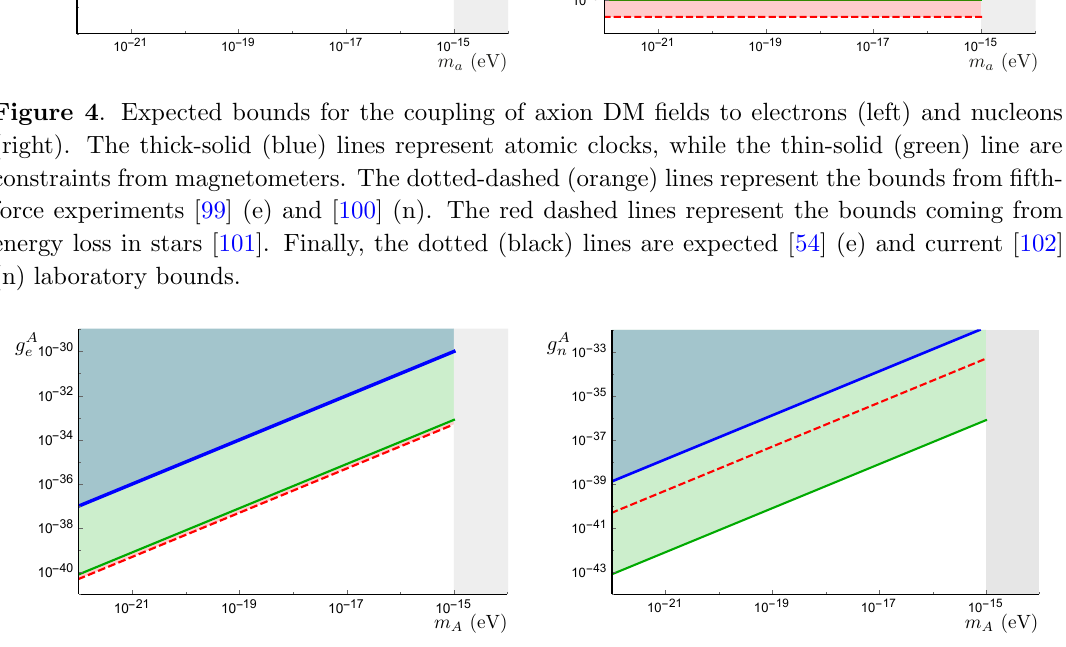
Figure 5 . Expected bounds on the coupling of axial field DM to electrons (l.h.s.) and neutrons (r.h.s.) from atomic clocks, thick-solid (blue) line, and magnetometers, thin-solid (green) line. The red dashed line represents the bound coming from stellar energy loss